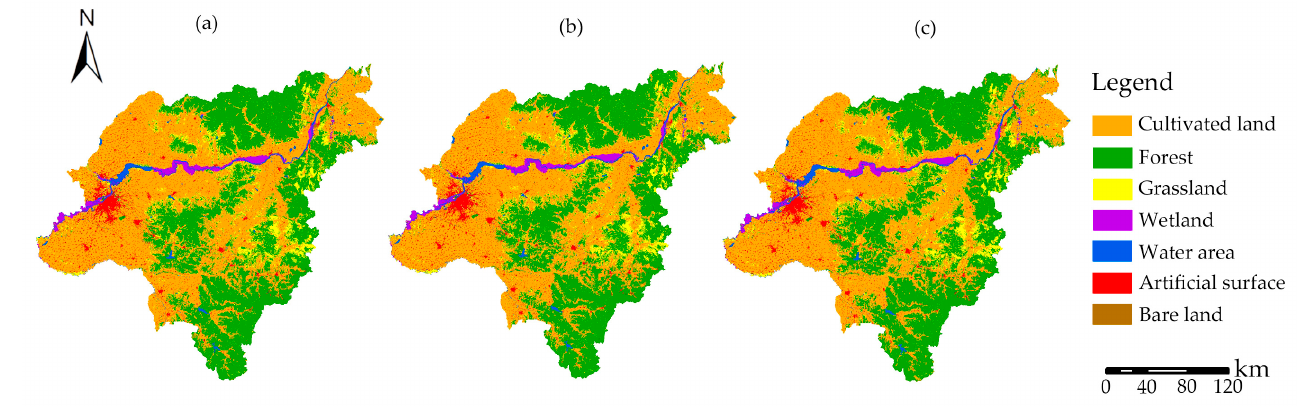
Figure 6. Land cover under different scenarios in Harbin in 2030. ( a ) Land cover in status quo development scenario; ( b ) land cover in ecological protection scenario; ( c ) land cover in economic development scenario.